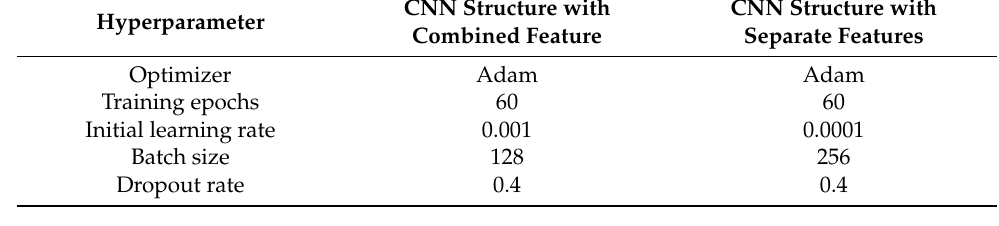
Table 5. The optimal hyperparameters for CNN structures with combined feature and CNN struc- tures with separate features after fine-tuning.